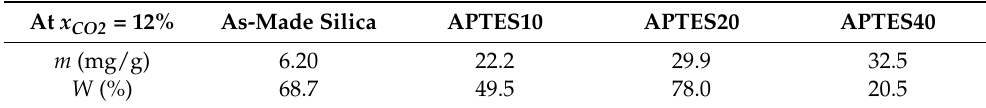
Table 5. The adsorption performance of as-made silica and amino-functionalized samples in terms of two characteristic parameters: inlet gas at 12% CO 2 ; confined layout.